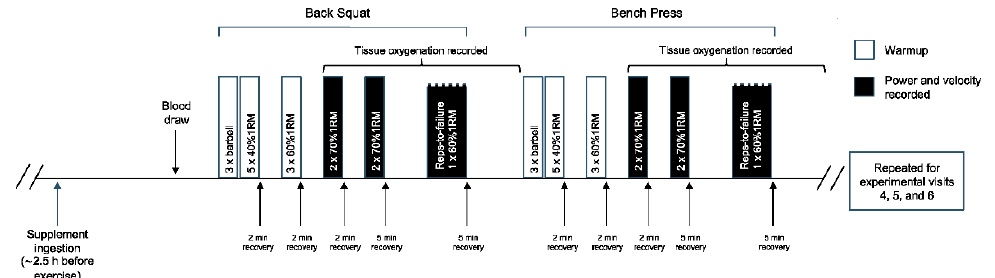
Figure 1. A schematic of the exercise protocol performed on visit 3, 4, 5, and 6 (i.e., experimental visits). 1RM = one repetition